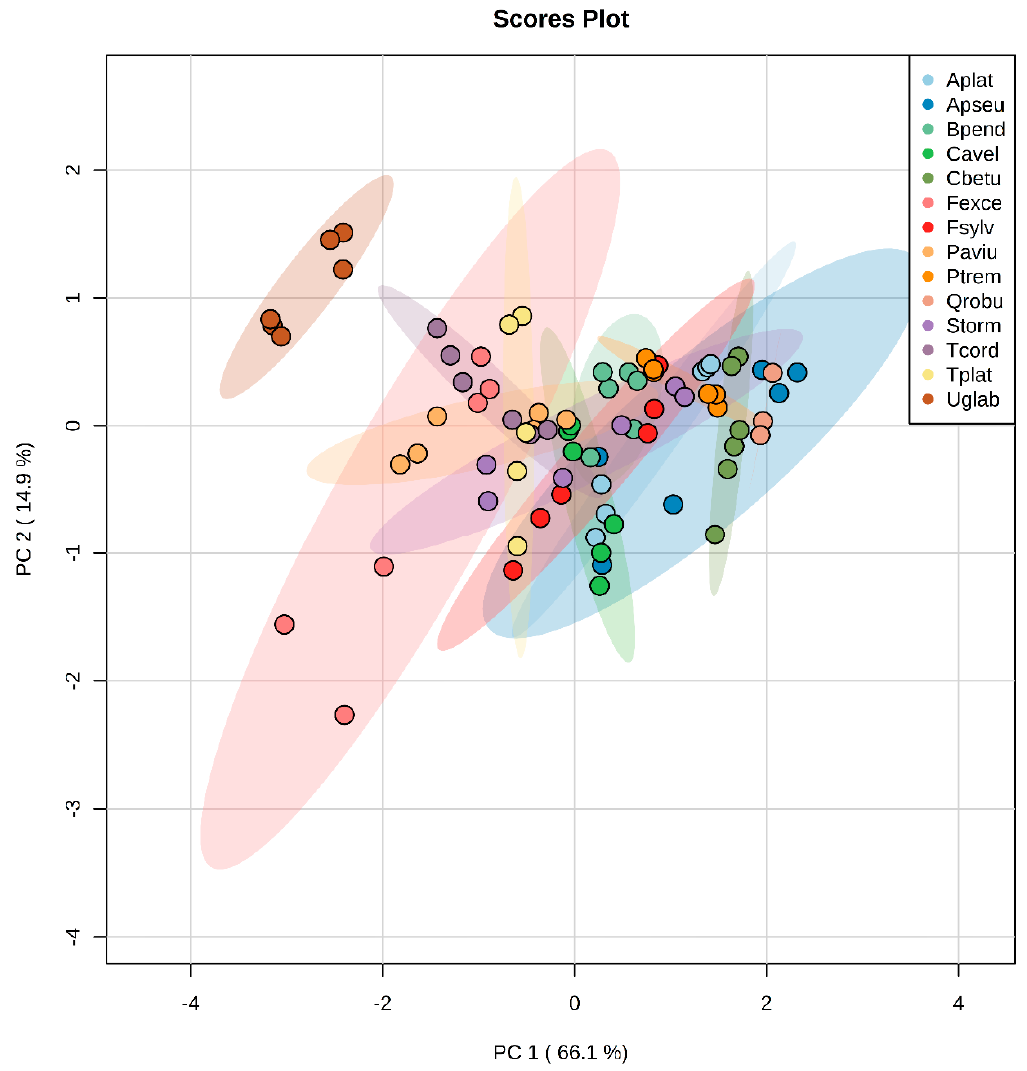
Figure 6. Two-dimensional score plot of principal component analysis computed with concentrations of total N, soluble amino acids, proteins, and phenolics in green leaves (after leaf development) for the combined years. Data for Q. robur is only available for the first year. Subgroups are shown in different colours. The explained variances (in percentage) are reported in x - and y -axes in the plot.